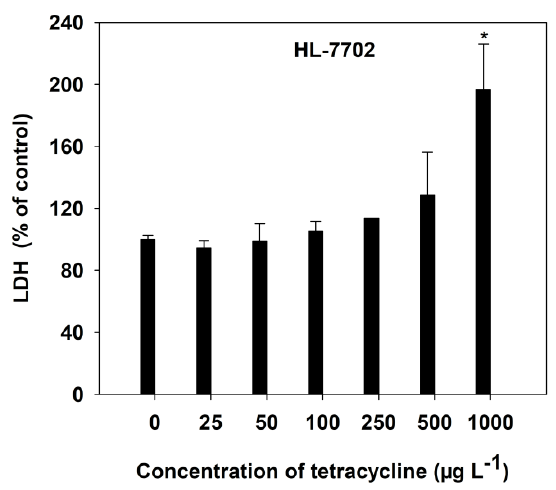
Figure 2. Effect of TC on LDH release in HL-7702 cells after 4-h incubation. Data are given as mean ± S.E. ( n = 3); “*” indicate significant ( p < 0.05) differences between controls (0 μg L – 1 ) and treatments. Table 1. Regression equations between cell viability; activities of lactate dehydrogenase (LDH), alanine transaminase (ALT), aspartate transaminase (AST), alkaline phosphatase (ALP) and catalase (CAT); contents of hydrogen peroxide (H 2 O 2 ) and malondialdehyde (MDA); the concentrations of added tetracycline (TC) in the normal human liver cell line HL-7702.